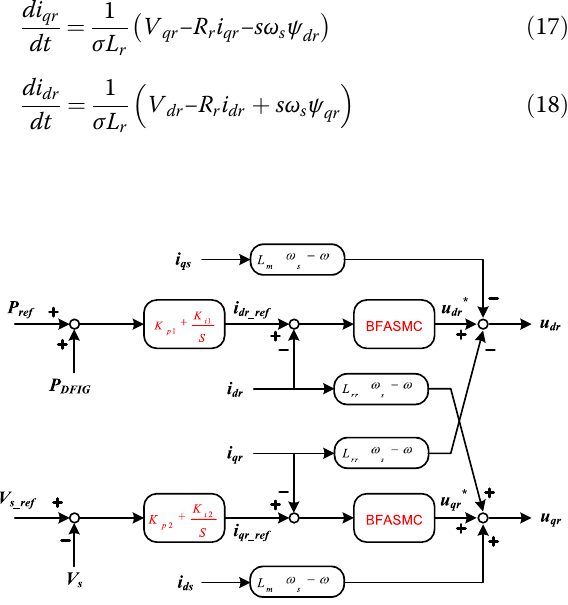
Fig. 2 Modified rotor side